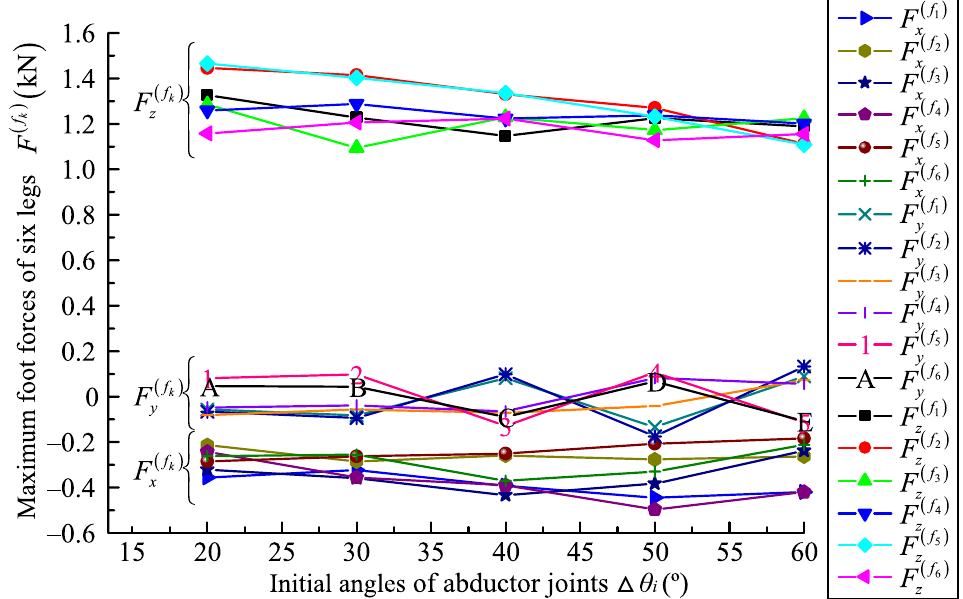
Figure 5 Curves of maximum foot forces with change in initial angle under ant-type tripod